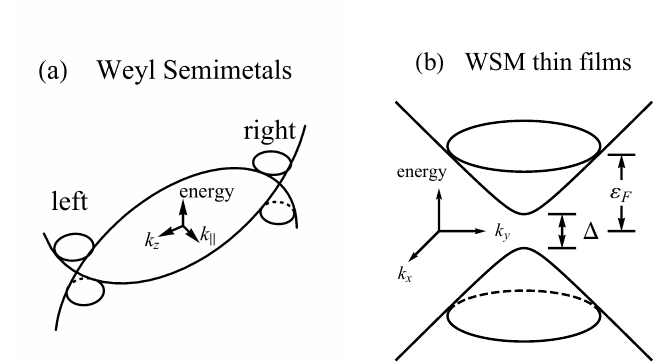
Figure 5. ( a ) a minimal sketch of the energy dispersion of a Weyl semimetal. We have defined = k 2 + k 2 ( k x , k y , k z ) represents the 3D wavevector. k z points along the preferred direction. k 2 x y while (cid:107) The conductance and valence bands cross linearly at the Weyl nodes, i.e., the left and right cones, and the nodes appear in pairs with opposite chirality number. A Dirac node appears when two oppositely-chiral Weyl nodes emerge together; ( b ) a schematic picture of the band structure in WSM thin films, where ∆ is the band gap and ε F is the Fermi energy.